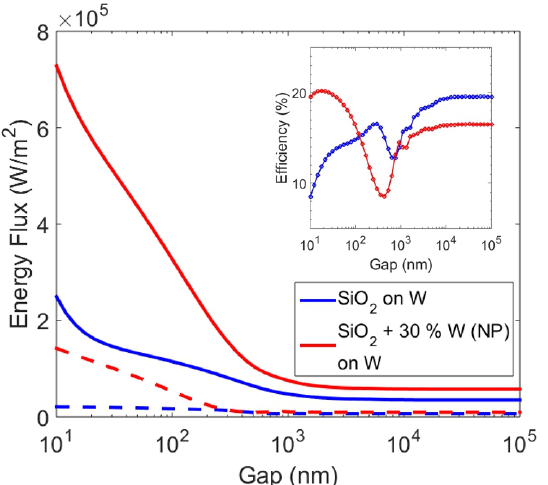
Figure 5. Total heat flux (solid lines) and output power (dashed lines) of PV cell as a function of separation between the emitter and PV cell for an emitter of pure SiO 2 film of 0.5 µ m and SiO 2 films with W nanoparticles. Inset shows overall efficiency of the corresponding thermophotovoltaic (TPV) systems plotted as a function of separation. NP: